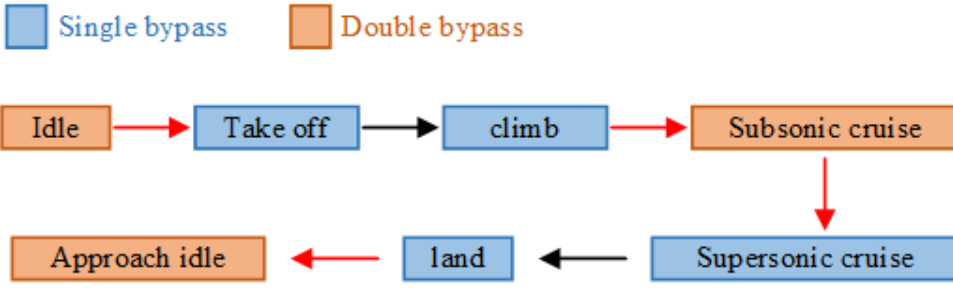
Figure 10. Schematic diagram of the flight cycle of an aircraft.